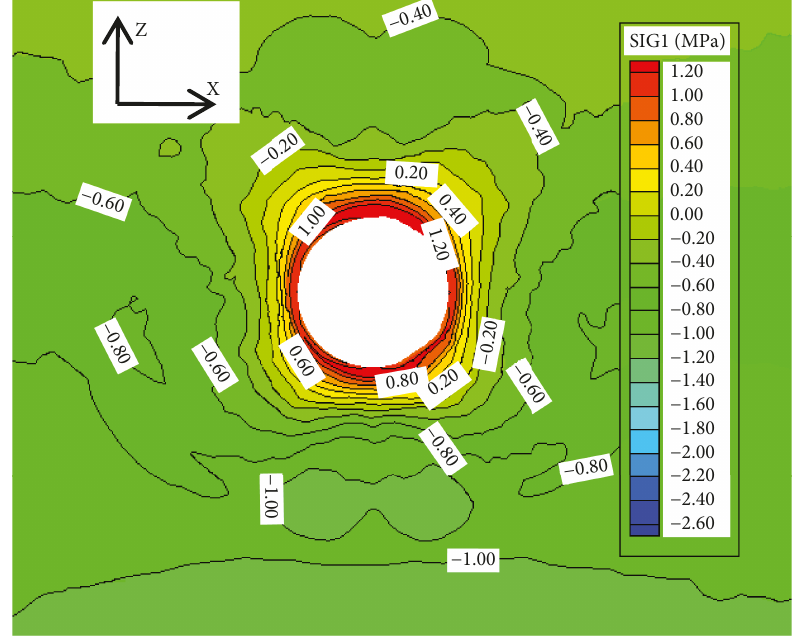
Figure 17: Major principal stress on section